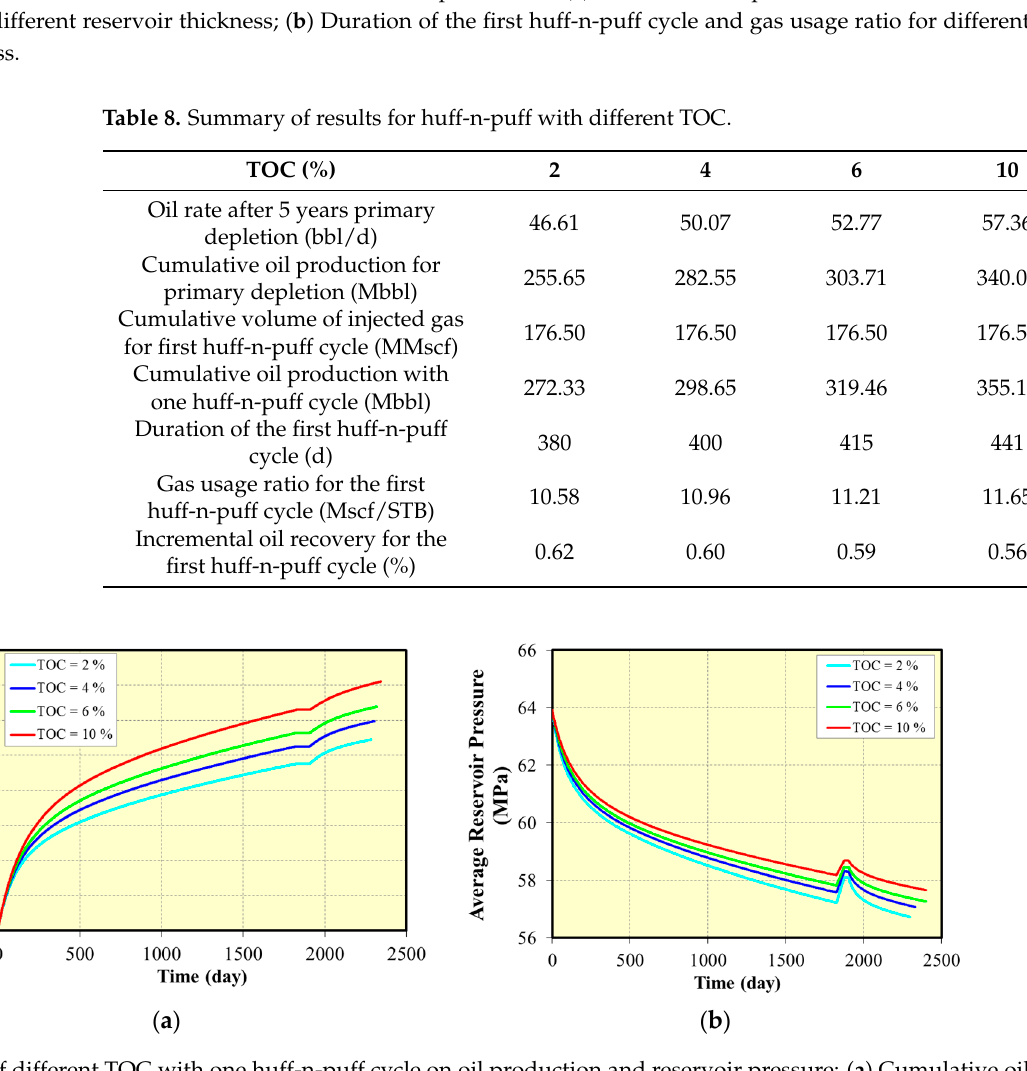
( b ) Figure 7. Correlation between TOC and huff-n-puff results: ( a ) Cumulative oil production and incremental oil recovery for different TOC; ( b ) Duration of the first huff-n-puff cycle and gas usage ratio for different TOC. 4.1.3. Pore Radius of Shale Matrix The nanopore confinement in shale reservoirs would lead to an increase in capillary pressure, which has a significant impact on the phase characteristics, critical properties,